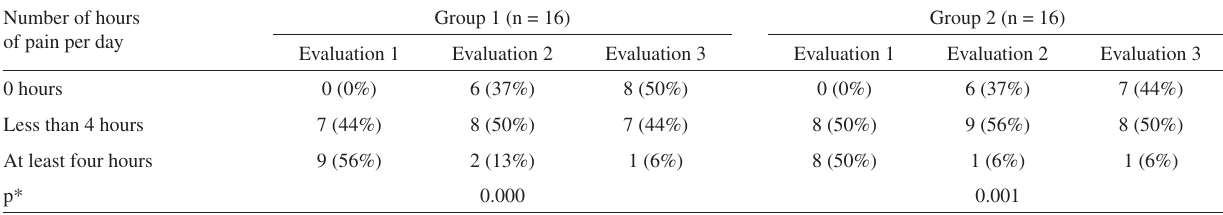
Table 2 – Number of hours of pain per day in Groups 1 and 2 before and after treatment Number of hours of pain per day